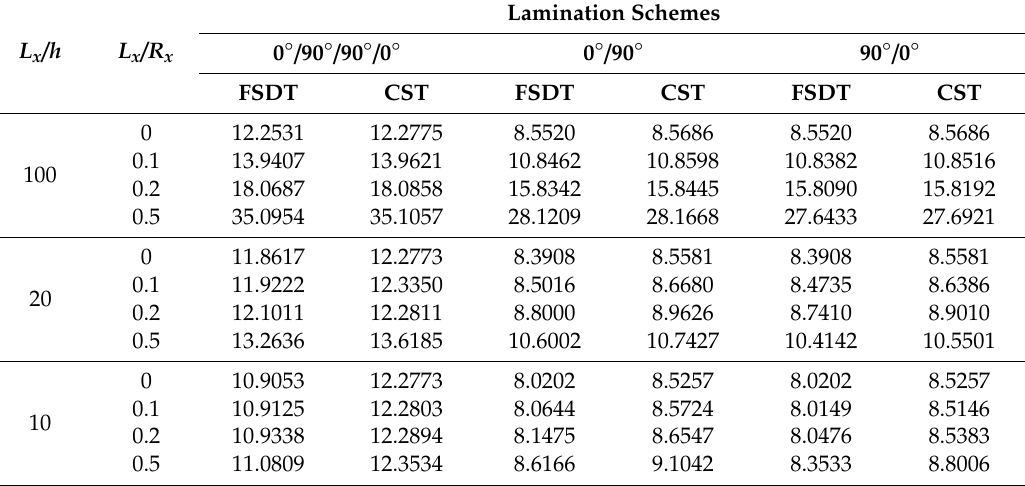
Table 7. The fundamental frequency parameter Ω for three types of layered composite shallow cylindrical shells for variety theories, length to thickness ratios L x / h , and length to radius ratios L x / R x with the SD-SD boundary